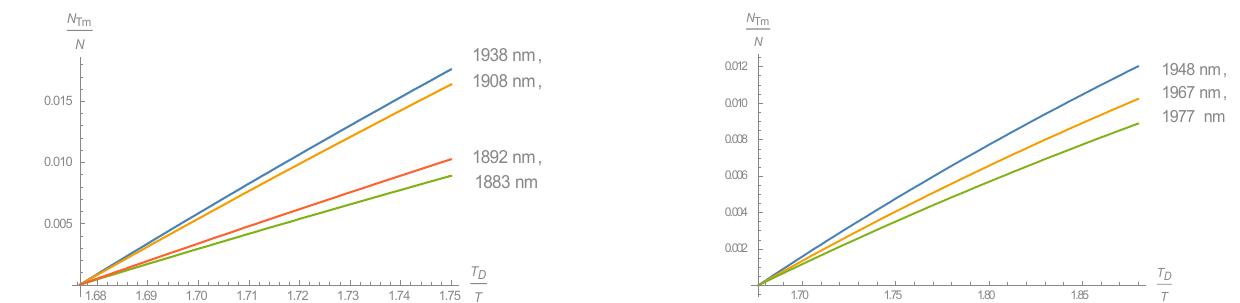
Figure 3. Concentration dependences of the cooling temperature at the excitation intensity F p = 5 × 10 21 cm − 2 s − 1 at wavelengths leading to the most efficient cooling. Table 4. Temperature values ∆𝑇 = 𝑇 (cid:2868) − 𝑇 for 𝑁 (cid:3021)(cid:3040) = 2 × 10 (cid:2870)(cid:2868) cm (cid:2879)(cid:2871) . λ ex , nm ∆ T ,